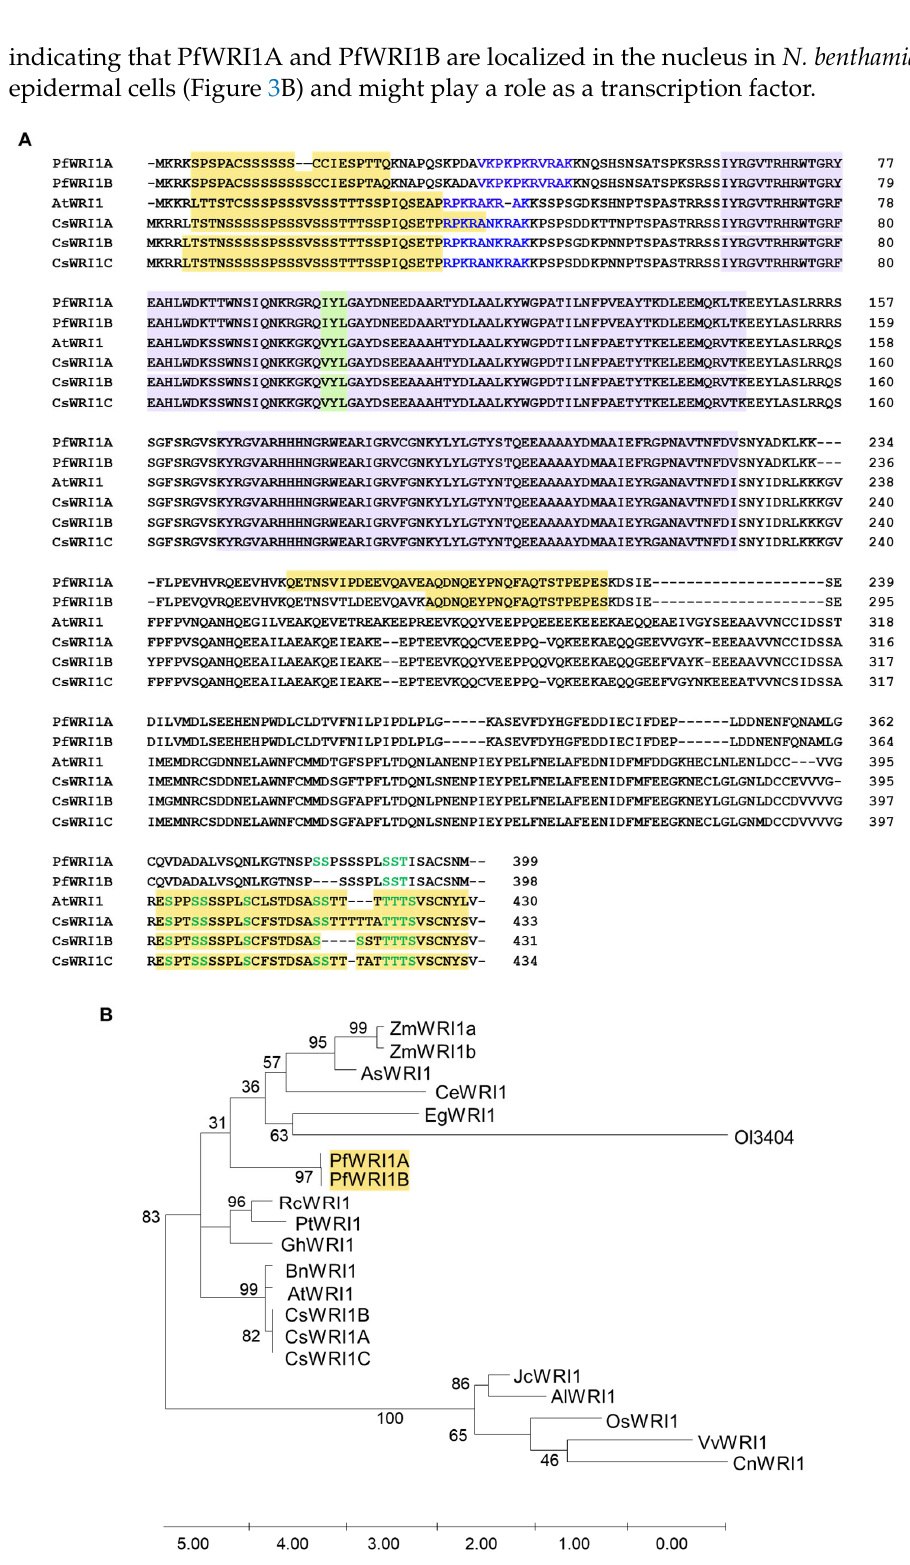
Figure 1. Alignment of the deduced amino acid sequences of WRI1 isoforms from P. frutescens , A. thaliana , and C. sativa and phylogenetic tree of PfWRI1 homologs from diverse plant species. ( A ) Whitish purple and green backgrounds indicate the conserved AP2/ERF DNA binding motifs and the transcriptional activation motif in WRI1, respectively. The predicted nuclear